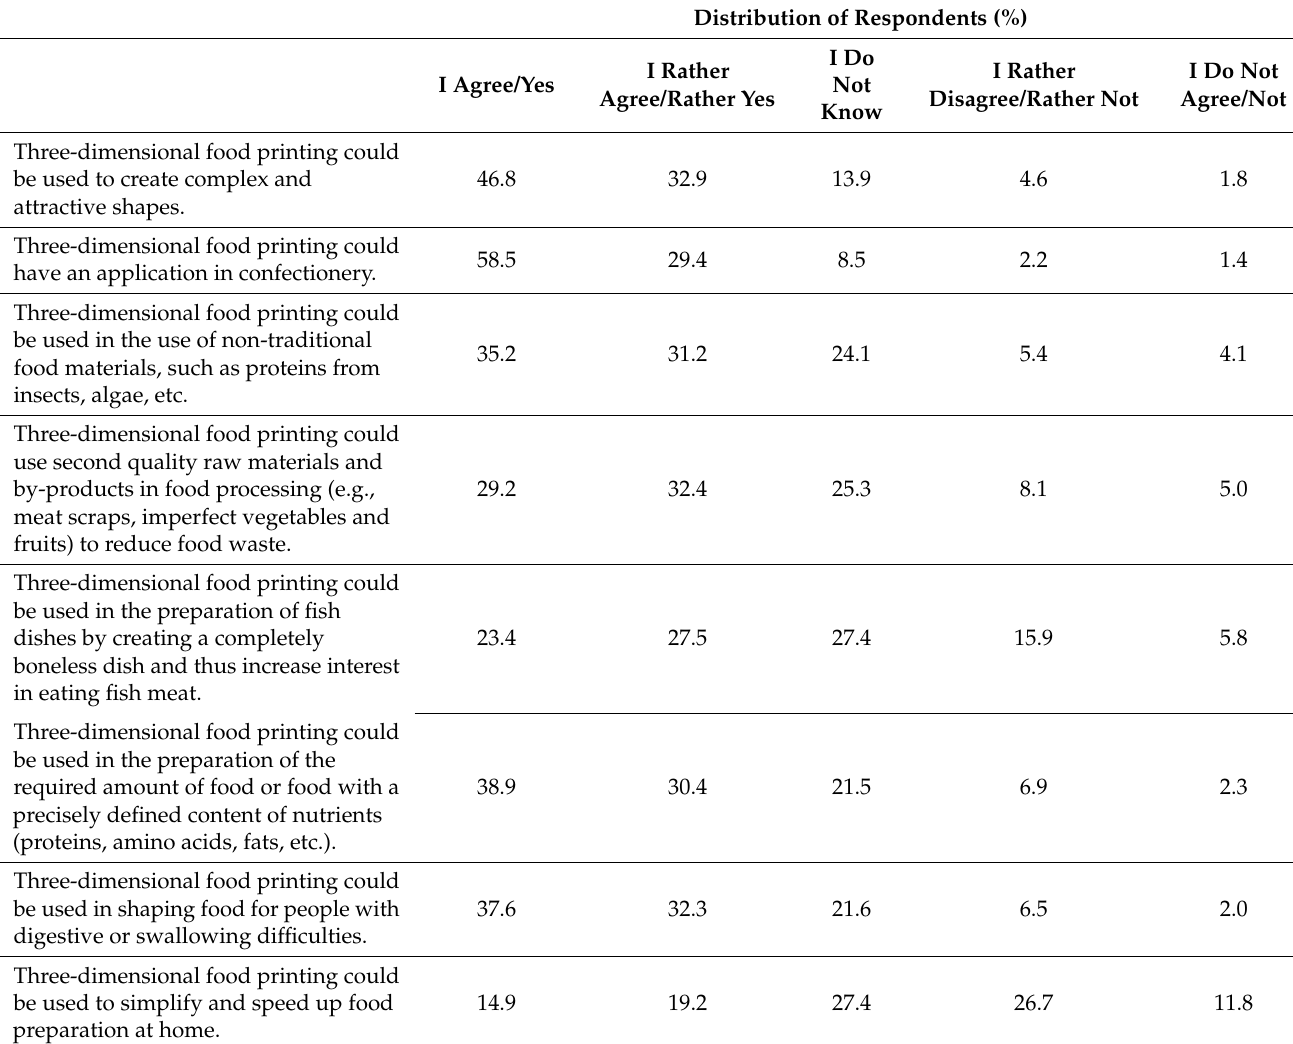
Table 4. Three-Dimensional Food Printing, Application. Distribution of respondents